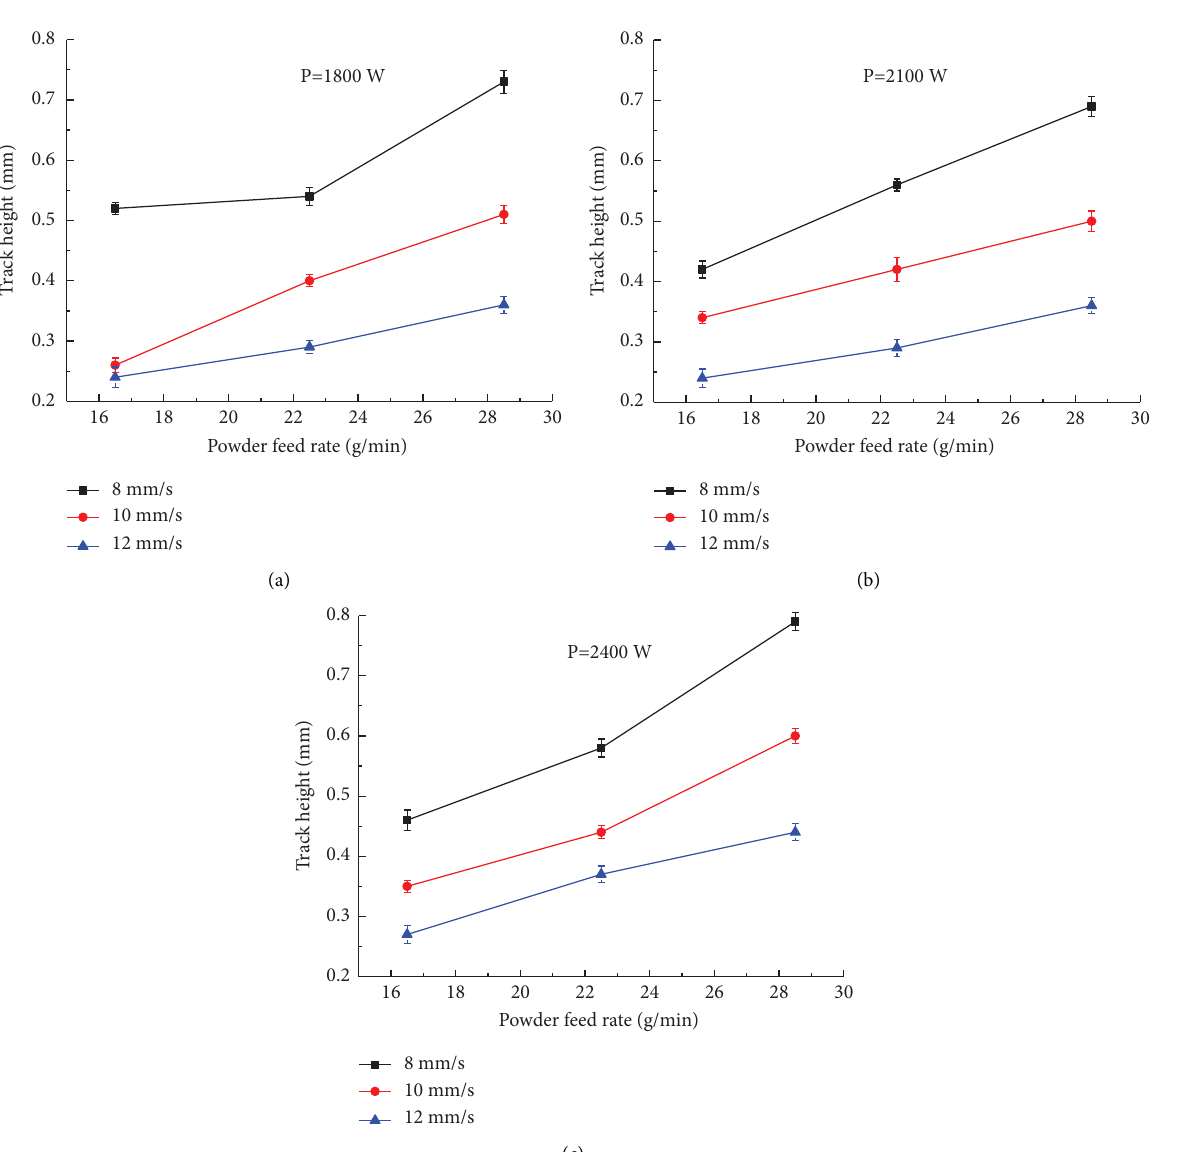
b to H b ). Te upper right number of each photograph is